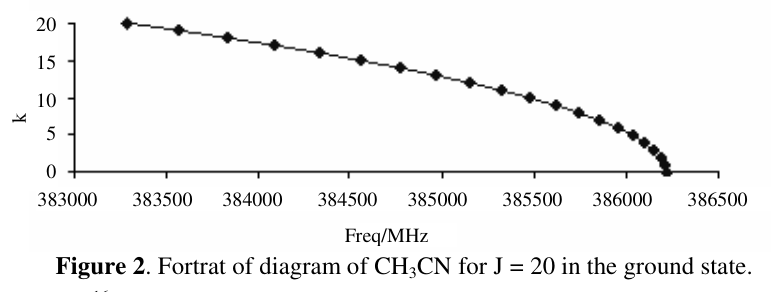
CN for J = 20 in the ground state. 3